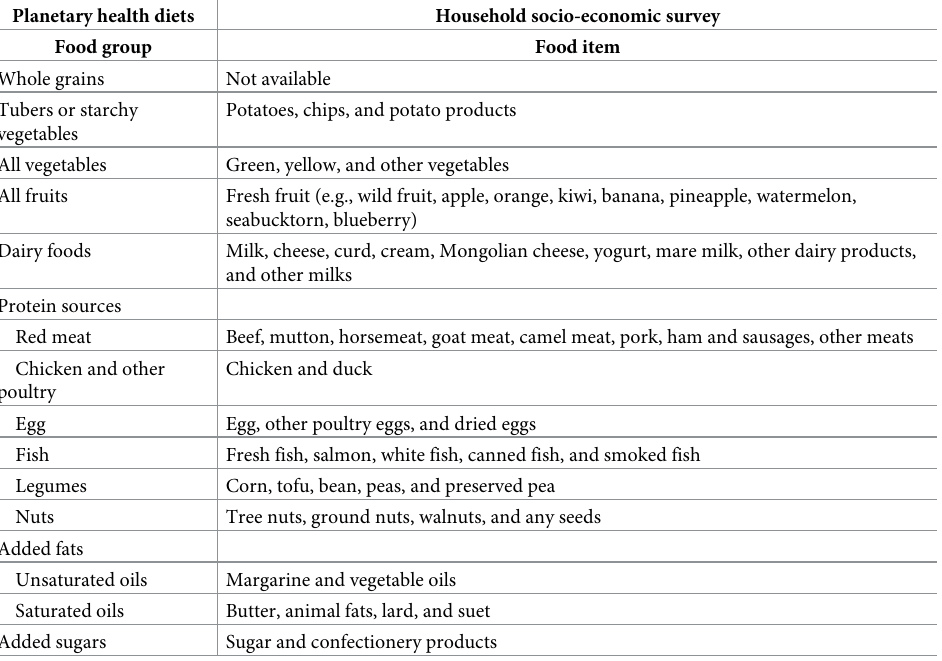
Table 1. Classification of food items in the household socio-economic survey based on the planetary health